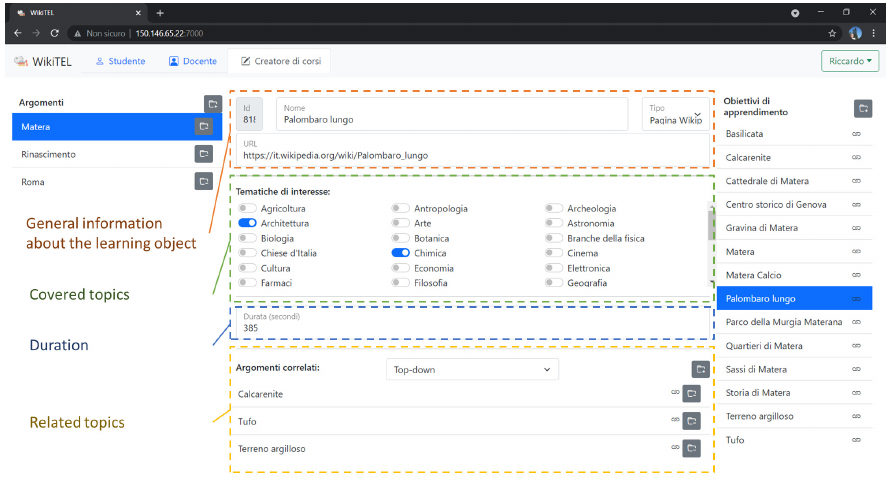
Figure 3. Editing the learning